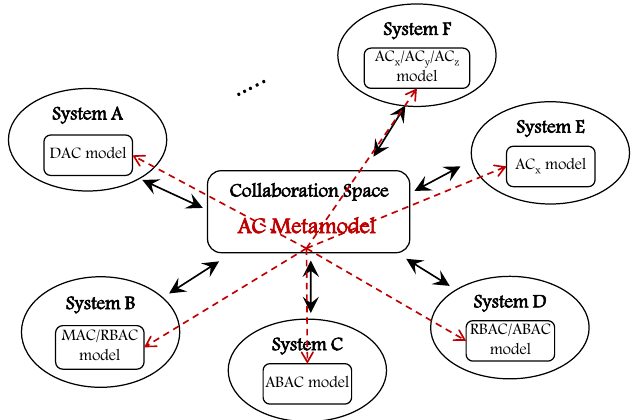
Figure 11. The concept of collaboration and interoperability of AC